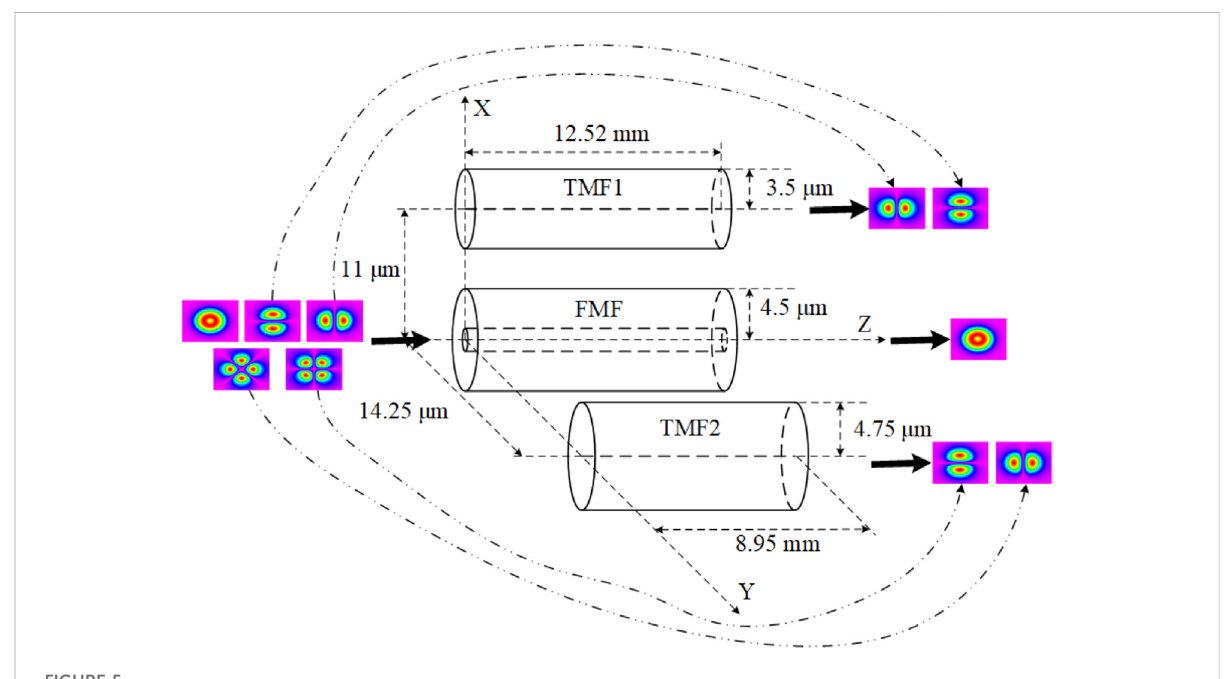
FIGURE 5 3D view of our proposed